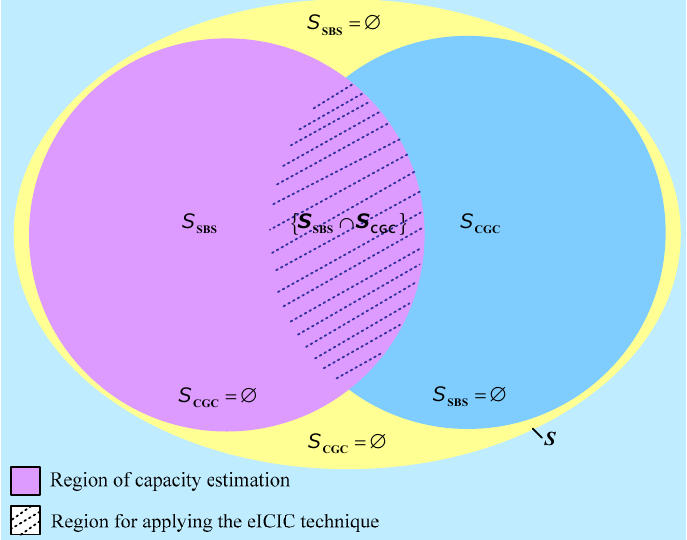
Figure 2. Sample space for the deployment of SBSs and CGC stations in an apartment.